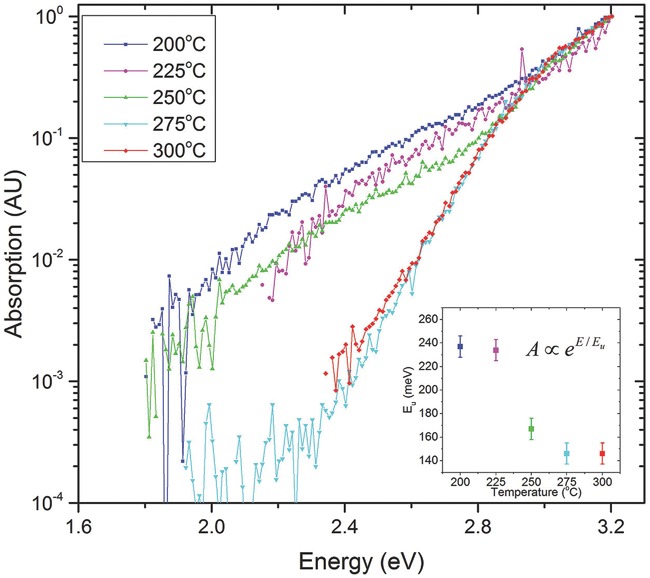
PDS data at different temperatures. The data are normalized with respect to the
maximum absorption close to the bandgap energy ≈3.2 eV to eliminate any
effects arising from different thicknesses between samples. The absorption
within 450 meV of the bandgap energy is used to calculate an Urbach energy
Eu (Figure S7, Supporting Information). This is a measure of
the disorder near the VB and is of the order of 140–240 meV as shown in
the inset.